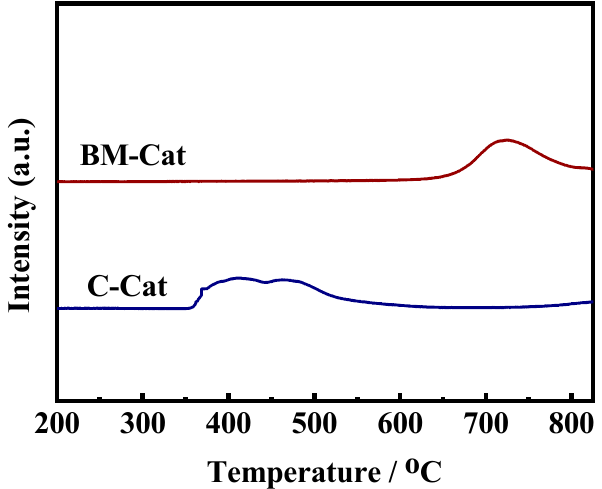
Figure 5. H 2 -TPR profiles of nickel-contaminated FCC catalysts. Scheme 1. Model reaction equations.